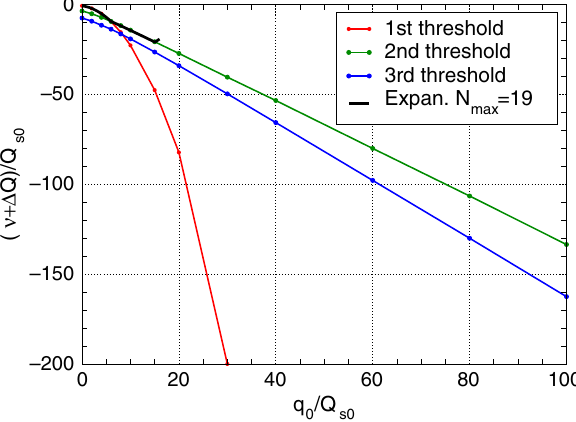
FIG. 6. Instability threshold of the lowest TMCI modes. The short black line is copied from Fig. 1 representing result of the ¼ 19 . Its deviation from the current expansion technique at N max < 15 . lowest mode does not exceed 1% at Δ Q=Q s 0